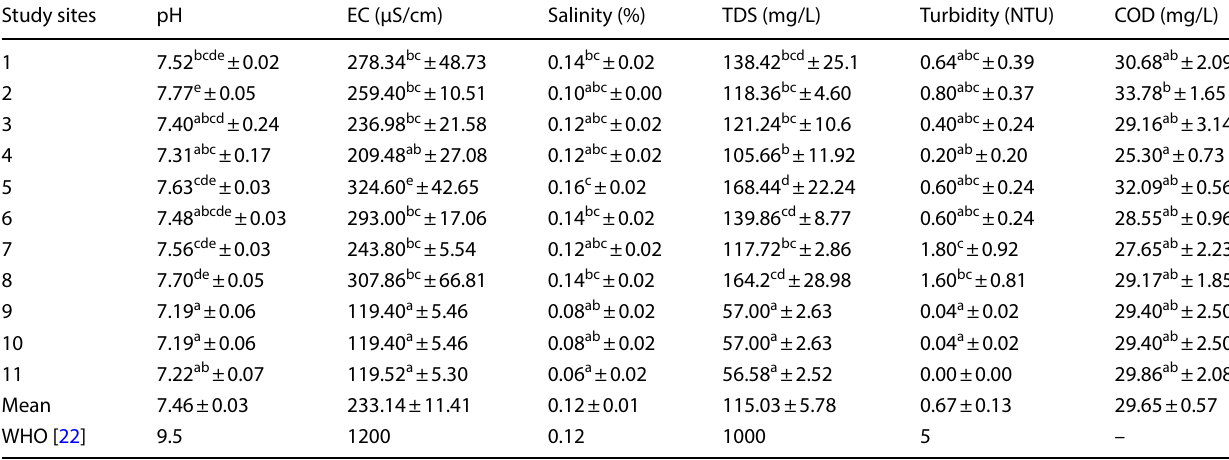
Table 2 Physico-chemical properties of stagnant water (pond) of cold desert high-altitude trans-Himalayan region